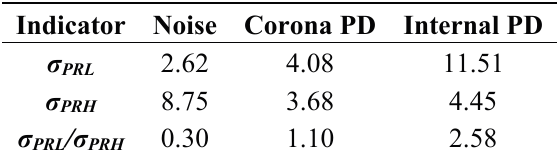
Table 5. Results obtained of the standard deviation for each cluster associated with PD and